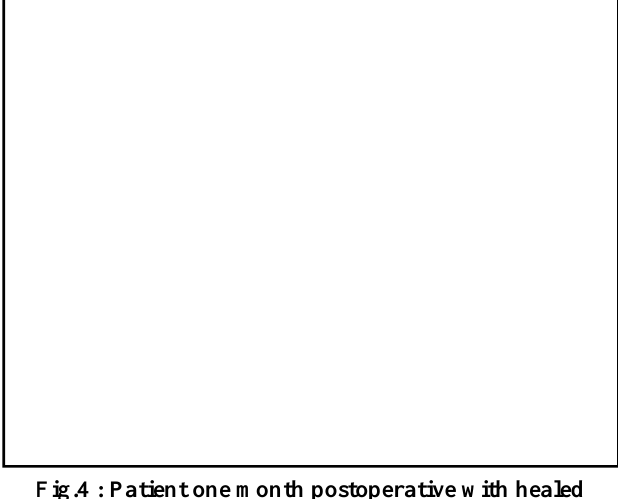
Fig.2 : Release of the upper lid.